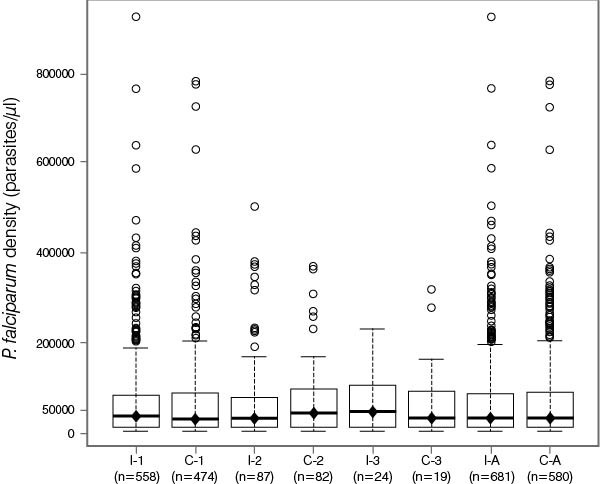
Distribution of P. falciparum density during SMRC5000 in individuals ≥5 years of age following screening campaign 3. I = intervention arm; C = control arm; numbers 1–3 indicate first, second and third episodes, and A any episode; n = number of subjects at each episode; central rectangles span the first quartile to the third quartile (IQR); the line inside each rectangle shows the median; the whiskers that extend from each box indicate the range of values that are outside of the intra-quartile range but close enough not to be considered outliers (a distance less than or equal to 1.5*IQR); ♦ = geometric mean.